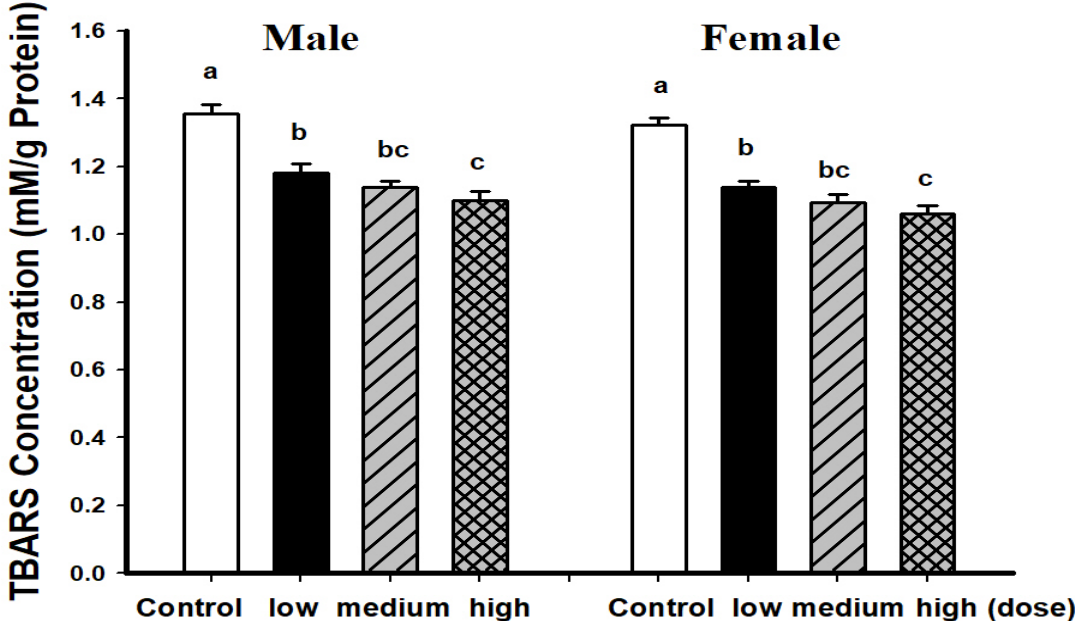
Figure 2. Thiobarbituric acid reactive substances (TBARS) levels in mice brain after 13 weeks feeding. Low dose group (108 mg/kg/bw/day), intermediate dose group (215 mg/kg/bw/day), high dose group (431 mg/kg/bw/day). Values are expressed as mean ± S.E.M. and analyzed by one-way ANOVA ( n = 10). Groups with different letters denote significant difference between each group ( p < 0.05).